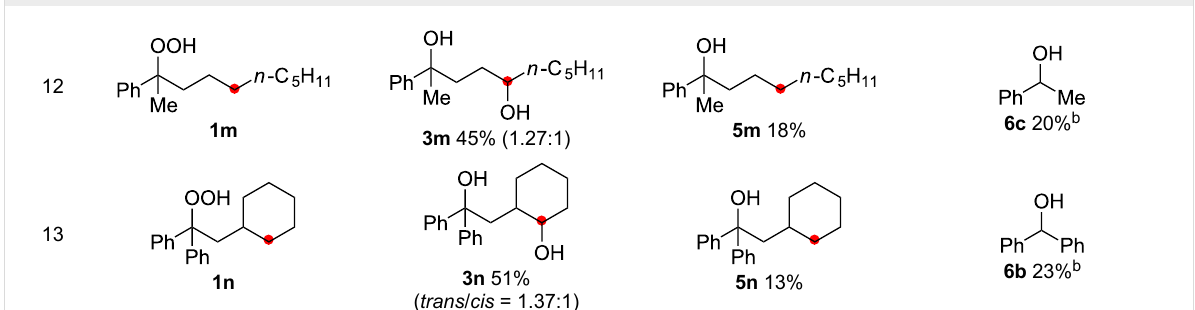
Table 2: Substrate scope: oxygenation of secondary C–H bonds. a (continued)